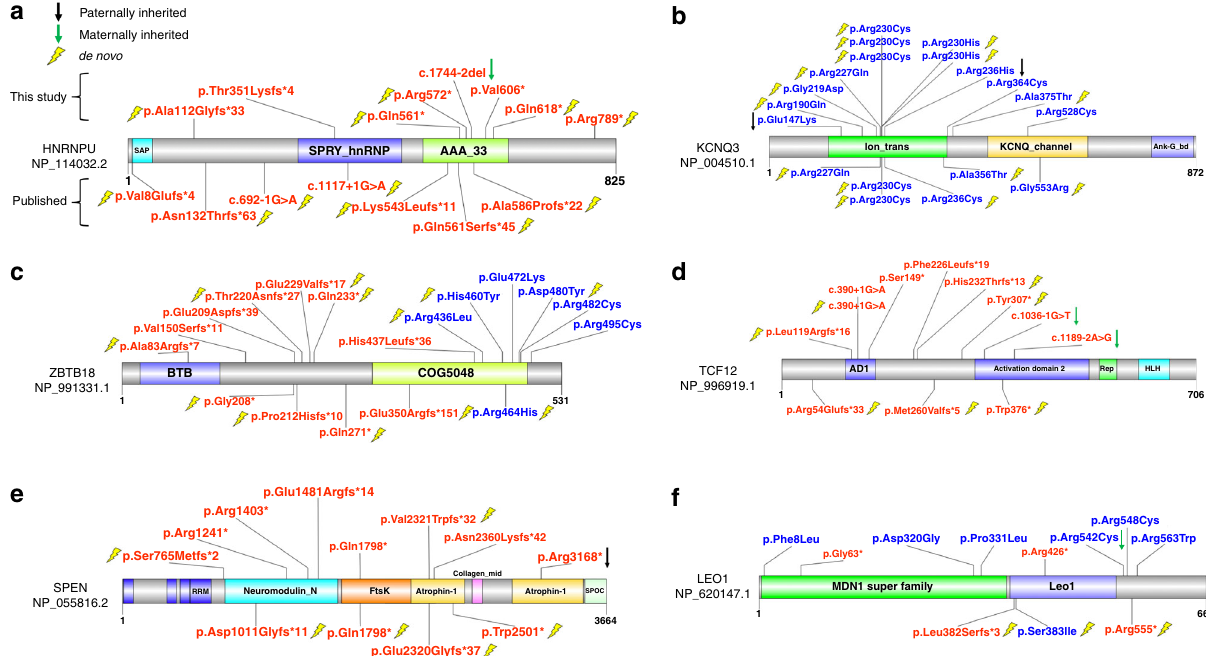
Fig. 4 Distribution of severe patient variants in six genes. Protein diagrams are shown for HNRNPU ( a ) KCNQ3 ( b ) ZBTB18 ( c ) TCF12 ( d ) SPEN ( e ), and LEO1 ( f ) with the same display metrics that applied in Fig. 3. Validated LGD (red) and MIS30 (blue) variants are plotted. Variants listed above the protein model are new to this study, while the ones below were published previously. Paternal (black arrow) and maternal (green arrow) inheritance are shown if determined. A yellow lightning bolt denotes a de novo